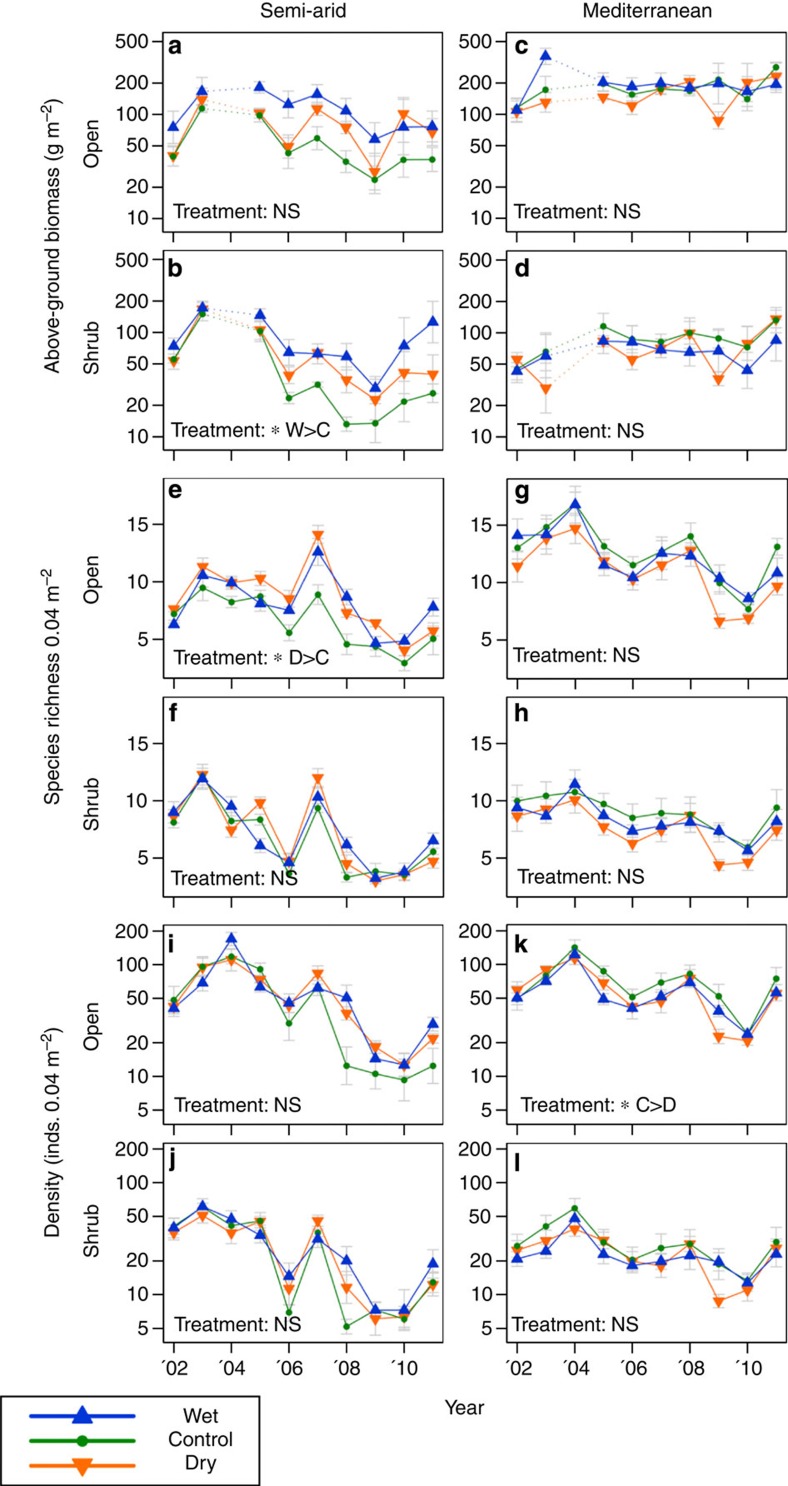
Response of three plant community variables to rainfall manipulation treatments.Above-ground biomass (a–d); species richness (e–h); and density (i–l). Data are expressed as mean (±s.e.). Above-ground biomass comprises of visual estimates calibrated by nearby destructive sampling, data for the 2003/04 season were missing. Density (number of individuals- inds.) and richness are expressed as mean per permanent quadrat (400 cm2). Linear Mixed Models were used to compare treatments (Supplementary Table 2), with overall treatment effects (DF=2,11; N=120 (biomass), or N=135 (density and richness)) indicated by an asterisk (*0.05>P>0.02) and significant contrasts (Tukey–Kramer adjusted) showing paired comparisons (w, wet; d, dry; c, control treatment). Of the 36 possible pairwise treatment comparisons, only 3 proved to have uncorrected P values <0.05, with no detectable difference between the wet and dry treatment in any variable: Biomass of under shrub communities at the semi-arid site showed a slight response to the wet treatment (wet > control P=0.028); species richness exhibited a minor treatment effect in open patches at the semi-arid site (dry > control P=0.031), and an opposite effect was detected for density of communities in the open patches of the Mediterranean site (dry < control P=0.021).